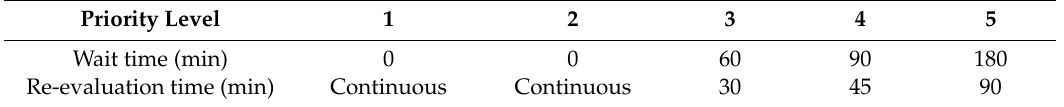
Table 2. Maximum waiting times for the patient (once classified) assigned to the ESI triage system in the Emergency Service Department of the General Hospital of La Palma.